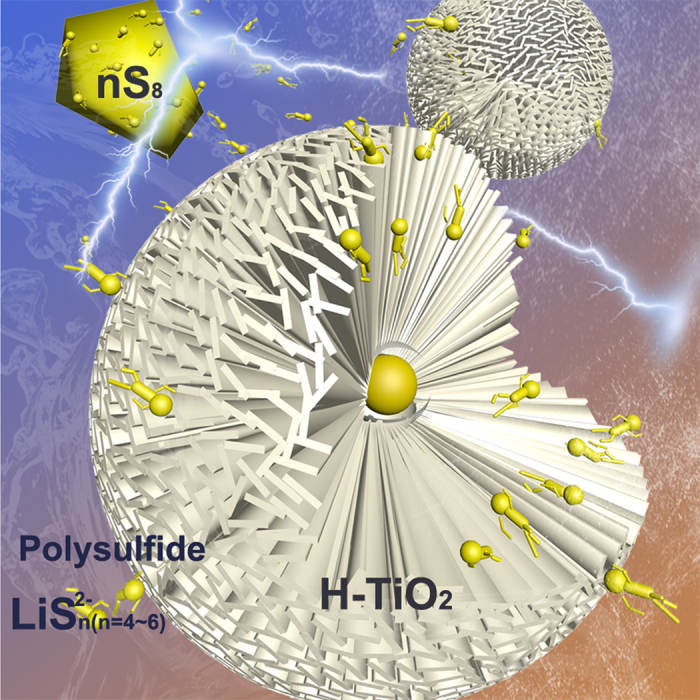
Schematic illustration of the H-TiO2 adsorption.